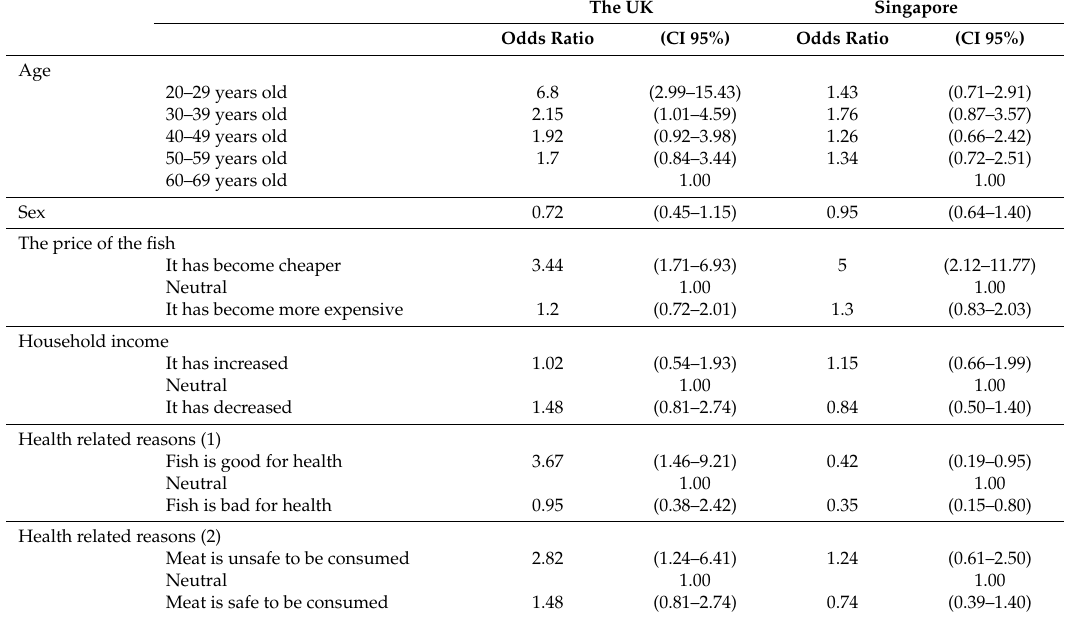
Table 3. Multiple logistic regression of increased desire to consume